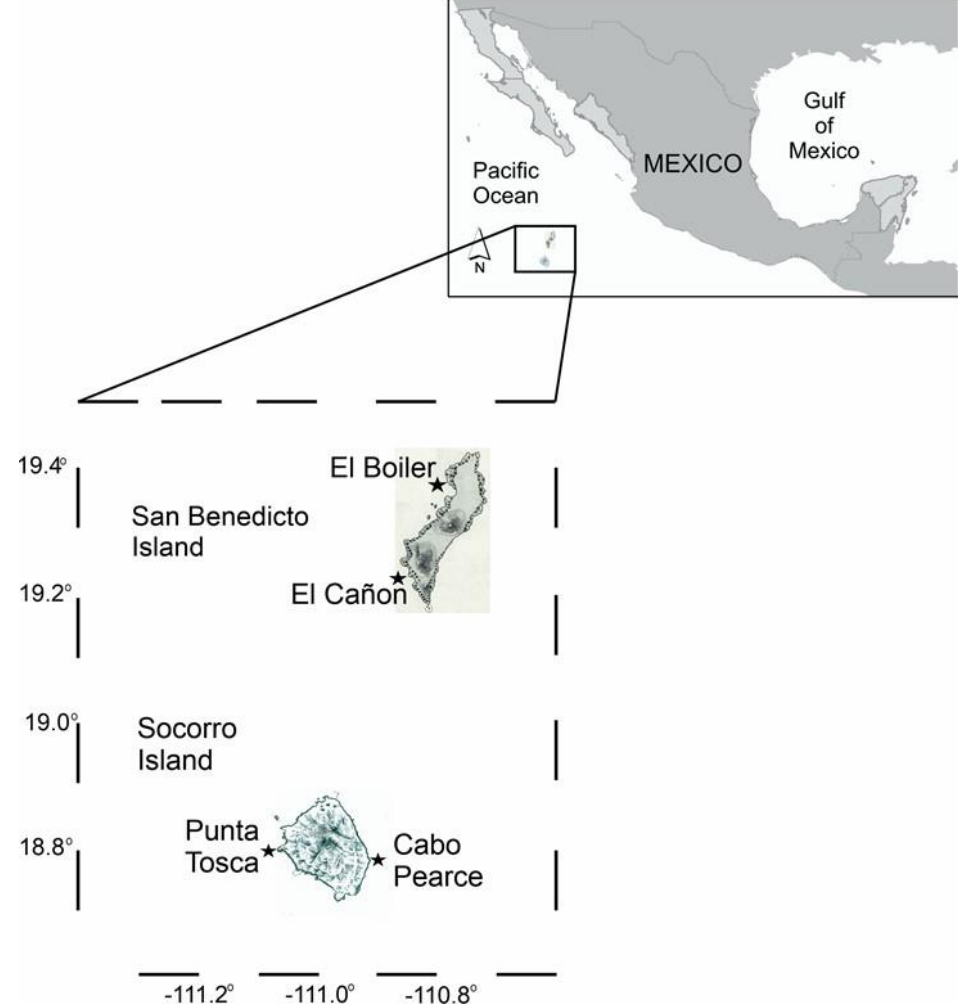
Figure 1. Location of sampling sites at the Revillagigedo Archipelago.